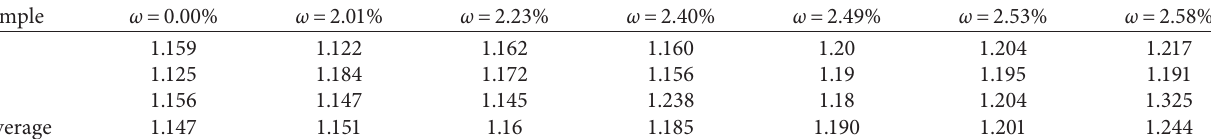
Table 3: Dynamic ductility coefficient of sandstone under different moisture contents.